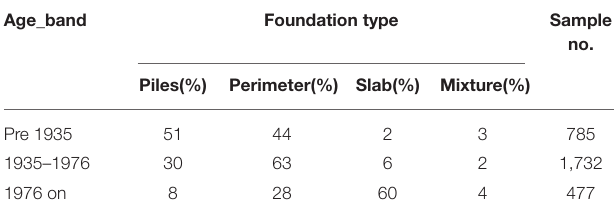
TABLE 6 | Distribution of foundation types in various age